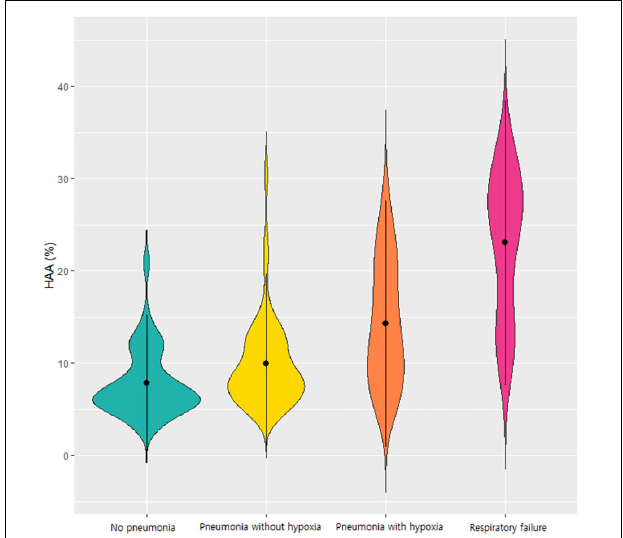
FIGURE 1 | Violin plot of the HAA values according to the respiratory outcomes of COVID-19. Each violin plot represents the distribution of HAA. HAA was sequentially increased in order of patients without pneumonia, those with pneumonia without hypoxia, those with hypoxia without respiratory failure, and those with respiratory failure. Abbreviation: HAA, high attenuation area; COVID-19, Coronavirus disease 2019.